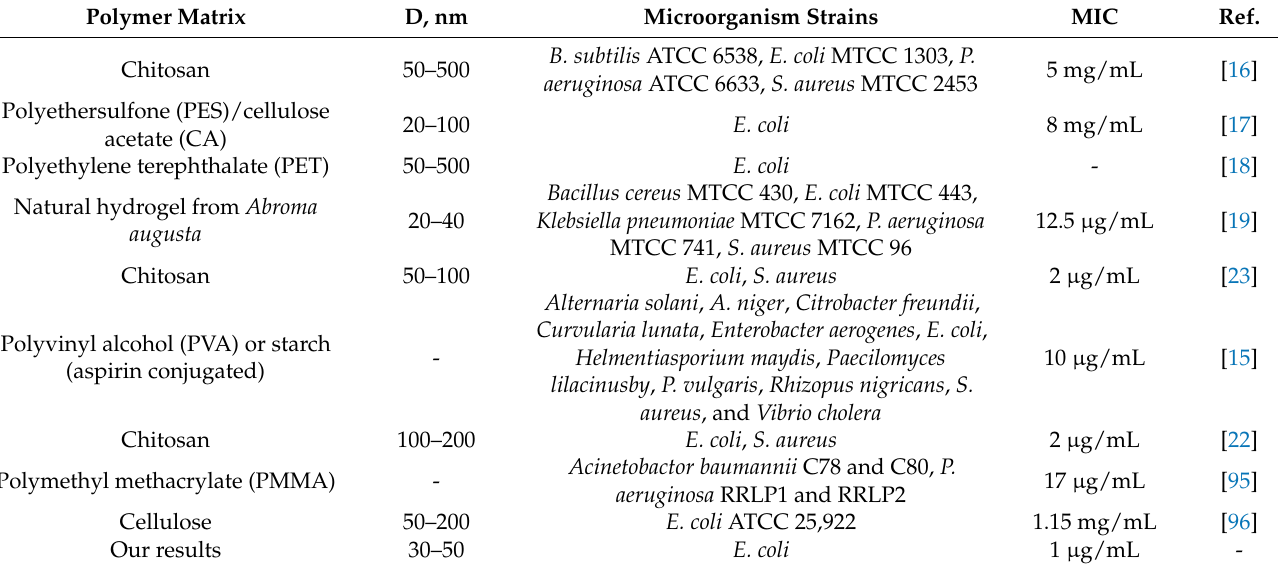
Table 1. Antimicrobial properties of polymers/Ag 2 O